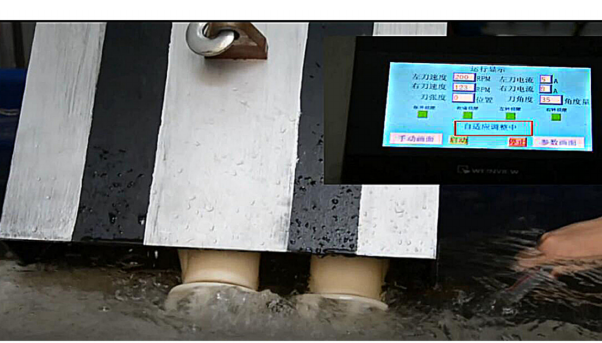
Figure 17. Experimental test